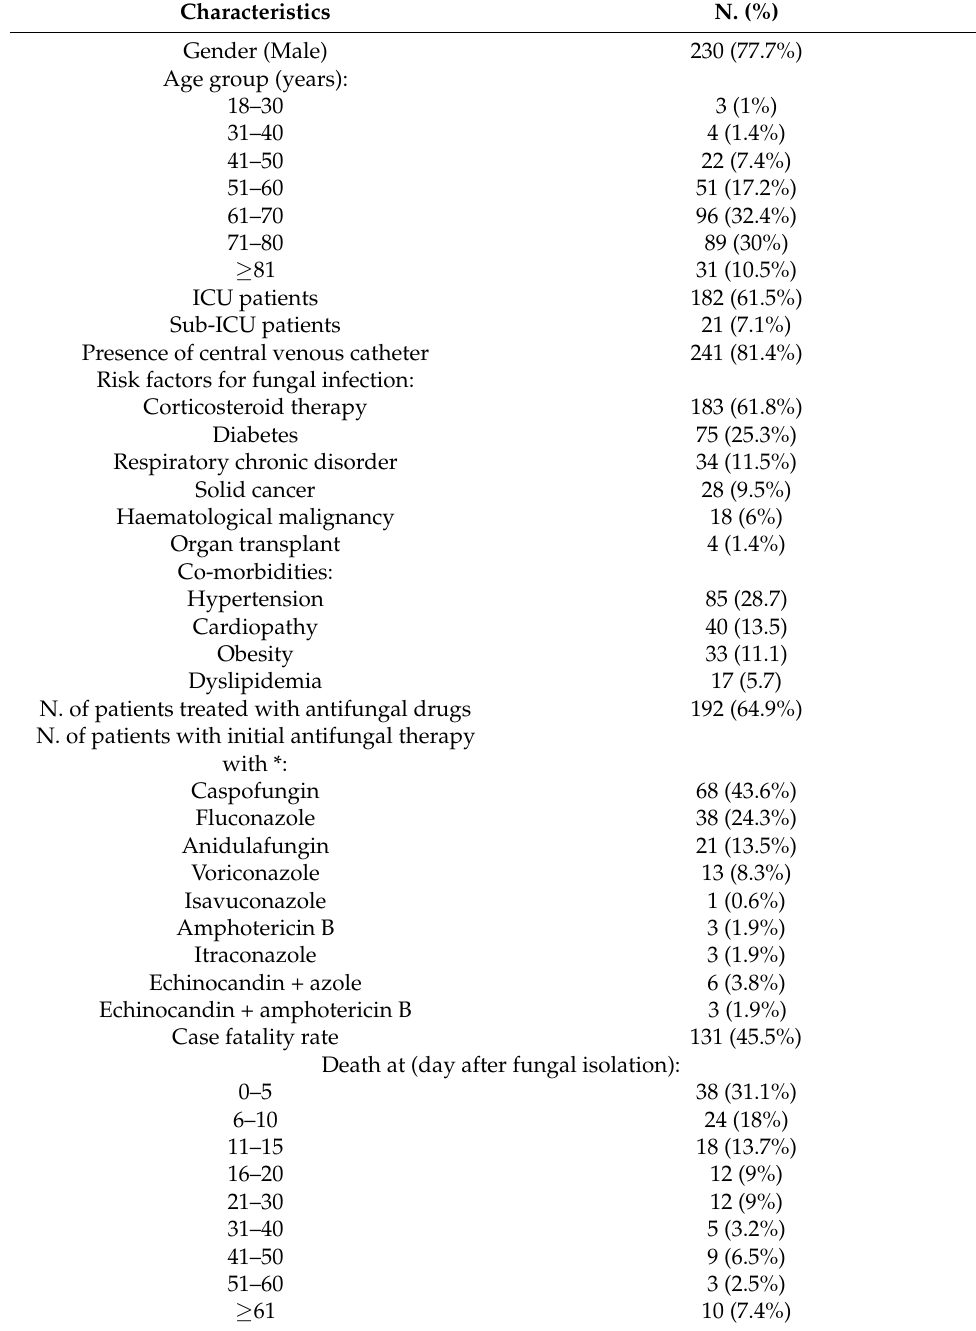
Table 2. Main characteristics of 296 COVID-19 patients with yeast